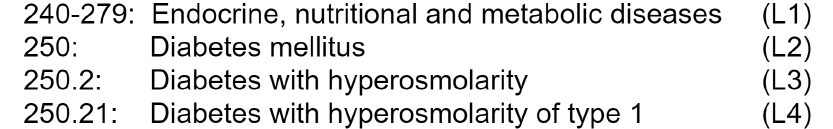
Figure 1. ICD-9 code structure with second through fourth layer representations and diabetes as an example.